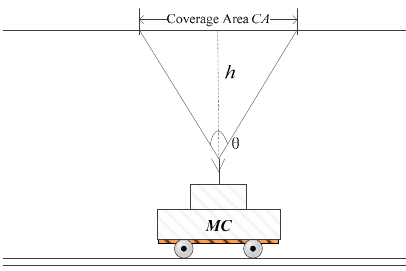
Figure 2. The sketch map of group node.